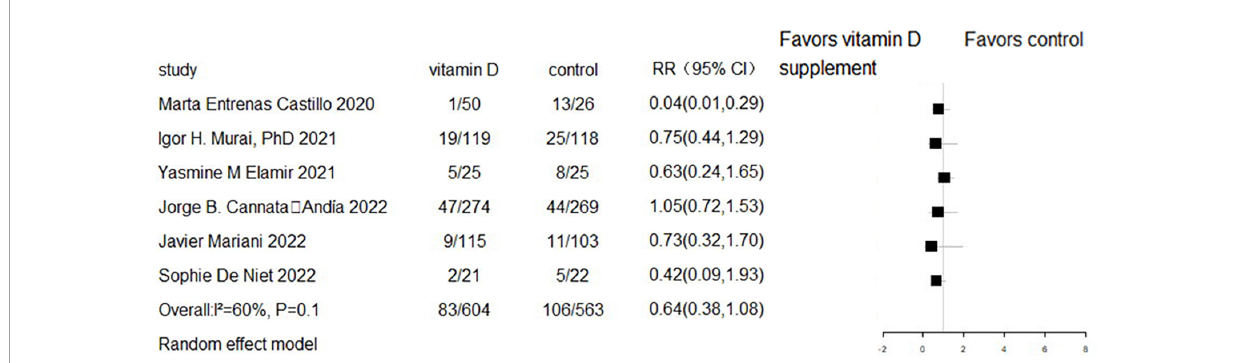
FIGURE6 Forest plot of RCTs for vitamin D supplementation on ICU admission.